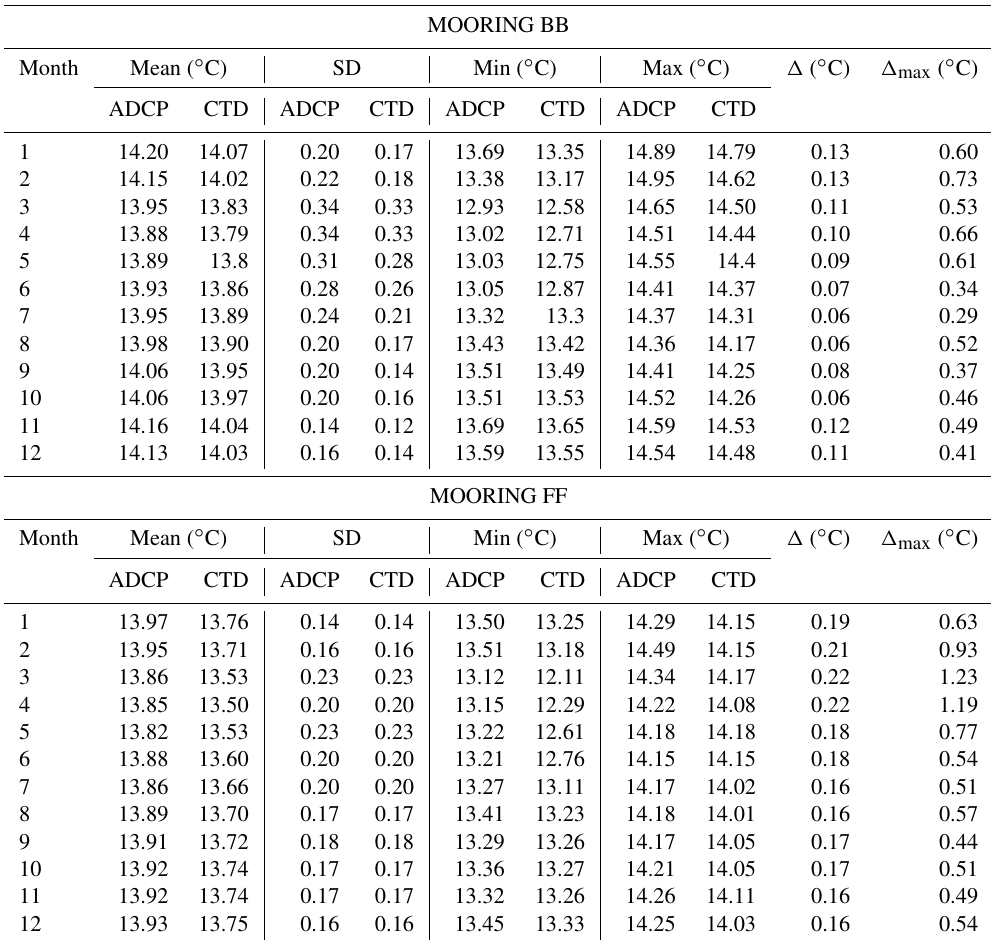
Table 4. Statistical parameters of temperature records of the two moorings grouped by months. SD indicates standard deviation and (cid:49) is the mean difference between temperature measured by ADCP and CTD and (cid:49) max is the maximum difference. The values reported in the table refer to original data (not